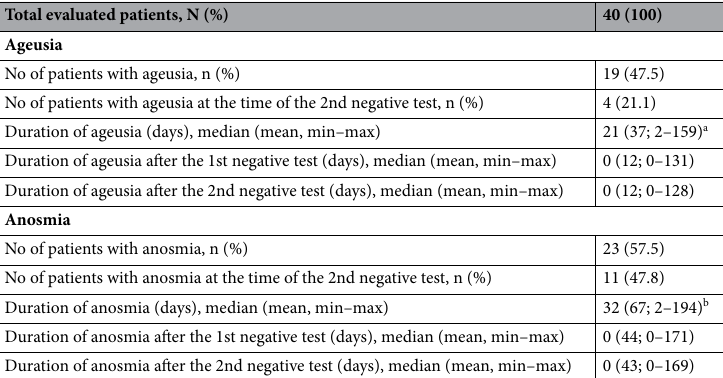
Total evaluated patients, N